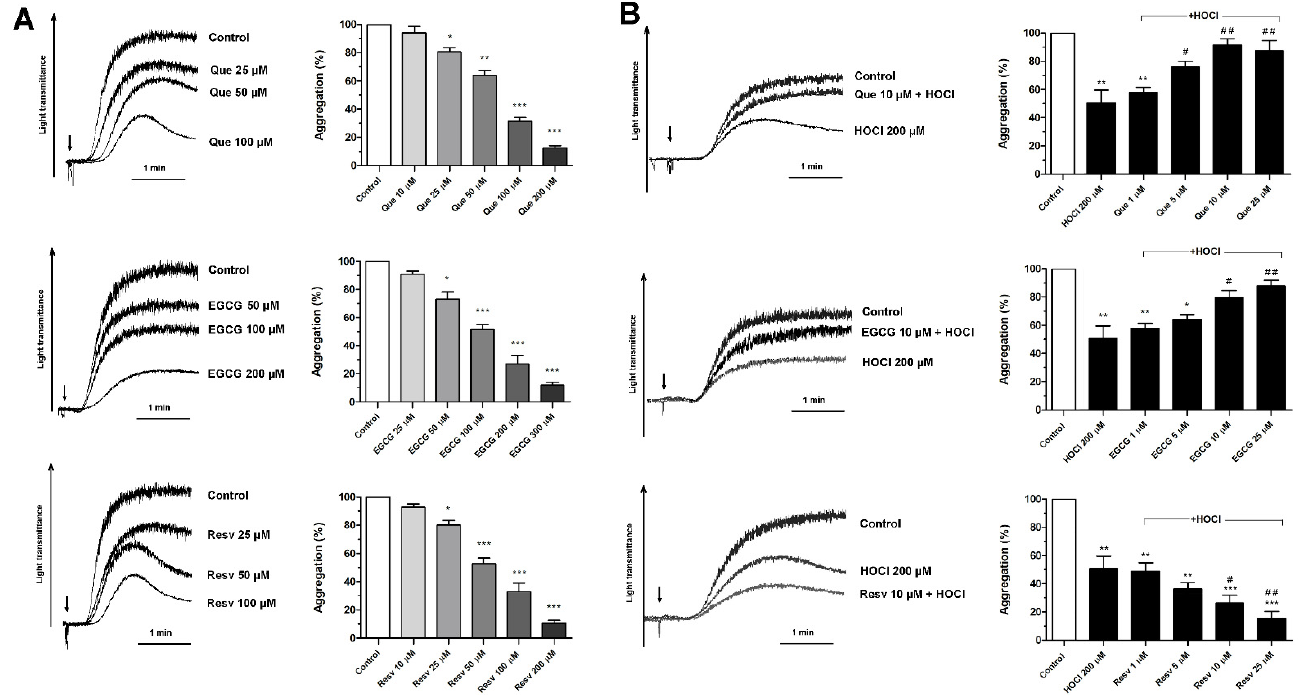
Figure 1. Effects of quercetin, epigallocatechin gallate, and resveratrol on platelet aggregation and on HOCl-evoked inhibition of aggregation. Samples of PRP were incubated with quercetin (Que), epigallocatechin gallate (EGCG), or resveratrol (Resv) for 5 min ( A ) followed by the addition of collagen (arrow, 5 μ g/mL), and platelet aggregation, measured as light transmittance through platelet suspension, was recorded. ( B ) PRP samples were supplemented with HOCl (200 μ M, for 5 min) or with indicated concentrations of Que, EGCG, or Resv added 1 min before HOCl. Next, aggregation was triggered by the addition of collagen (arrow, 5 μ g/mL). Control samples contained an appropriate volume of vehiculum: ethanol (used as a control for Que and Resv) or water (used as a control for EGCG). Representative aggregation curves from one experiment (out of six) and extent of aggregation are presented. Aggregation obtained in the presence of only collagen was considered as maximal aggregation. Data are means ± S.D. from n = 6 experiments. * p < 0.05; ** p < 0.01; *** p < 0.001 vs. control (sample supplemented with collagen, ( A , B )). # p < 0.05; ## p < 0.01 vs. sample supplemented with HOCl 200 μ M ( B ).